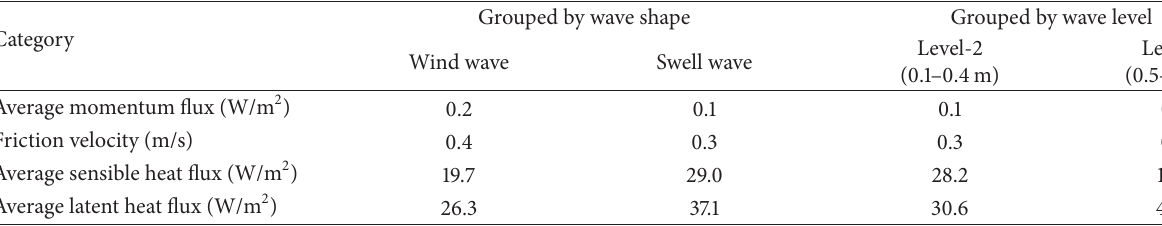
Table 3: Wave-coherent momentum flux and heat fluxes.